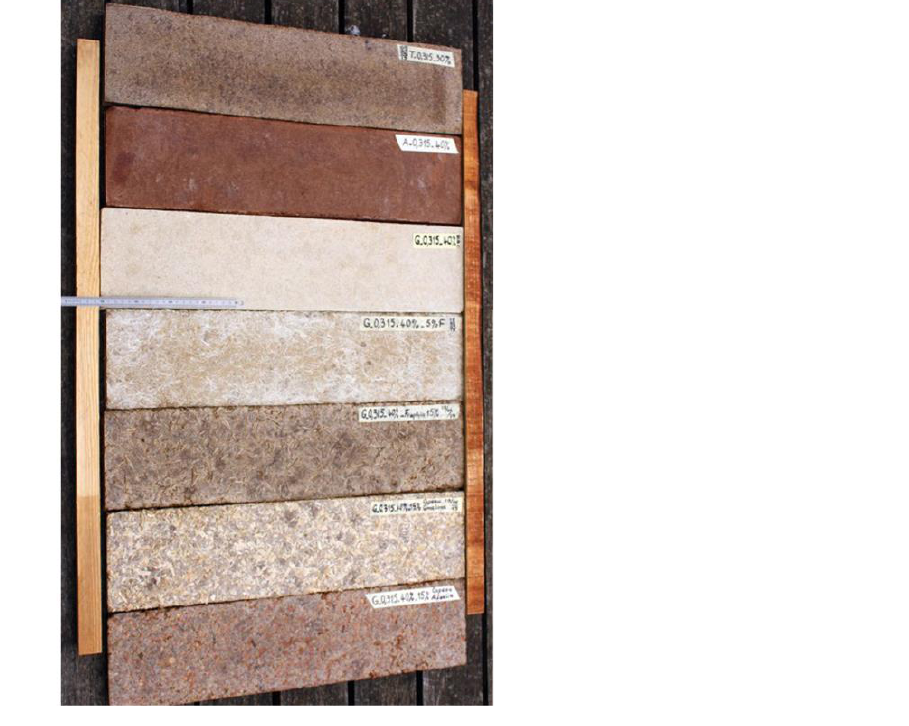
Figure 31. Sawdust-based panels of different wood species. Reprinted with permission from ref. [74].